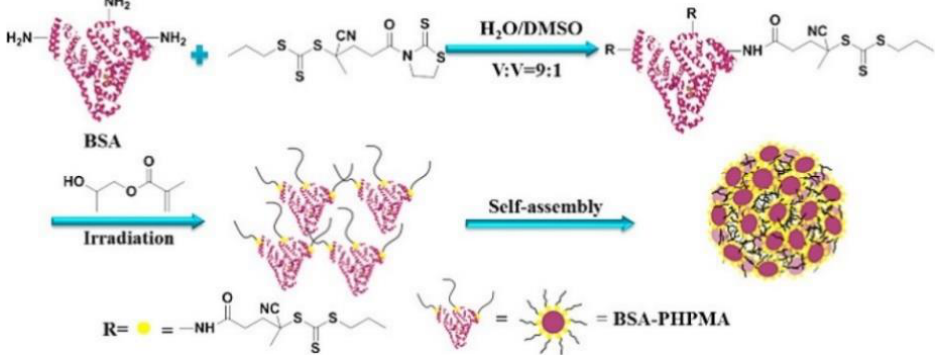
Figure 16. Synthesis of BSA Macro-CTAs and in-Situ Polymerization-Induced Self-Assembly of polymer biconjugate nanoparticles. Reproduced with permission from ref. [100].